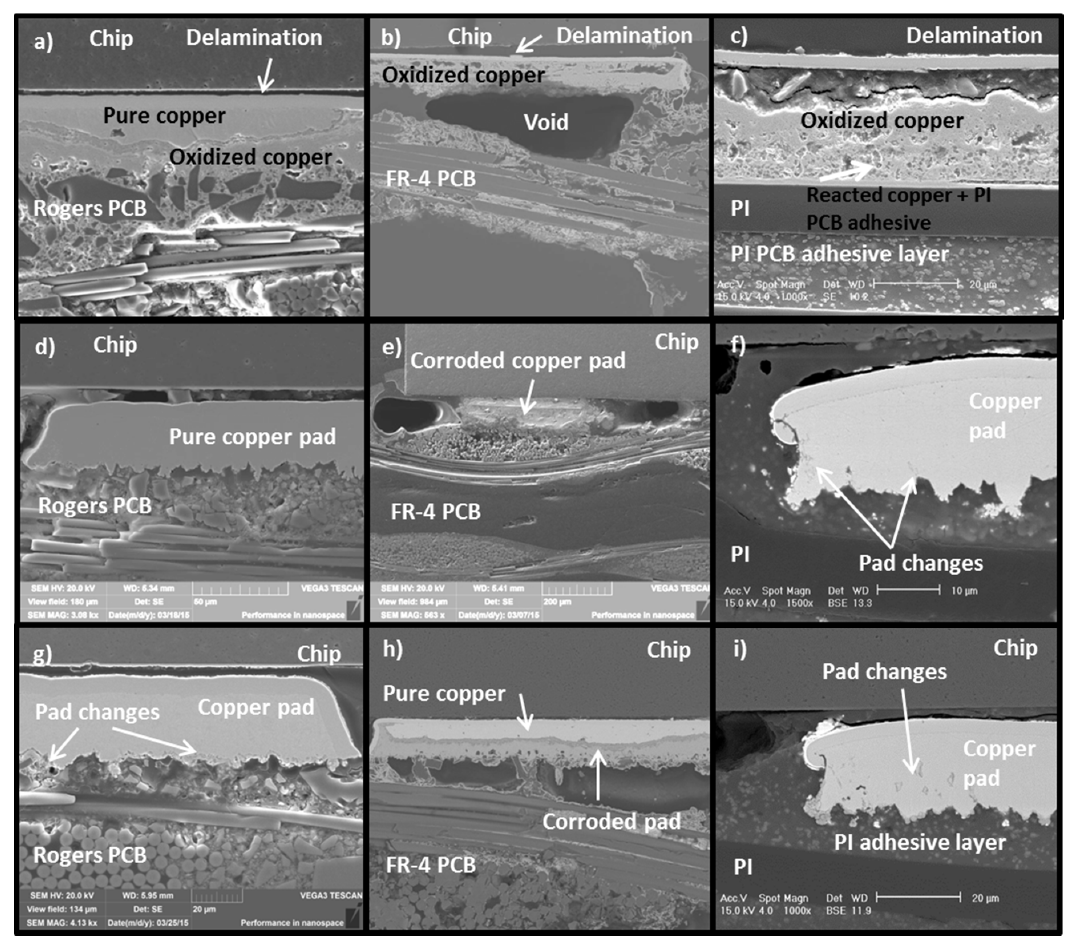
Figure 19. SEM micrographs of different PCBs exposed to varying temperature treatments. Top row: Cross ‐ section after 3000 h at 200 °C for ( a ) Rogers PCB; ( b ) FR ‐ 4 PCB; ( c ) PI PCB. Middle row: Cross ‐ section after 480 h at 200 °C for ( d ) Rogers PCB; ( e ) FR ‐ 4 PCB; ( f ) PI PCB. Bottom row: Cross ‐ section after 60 h at 240 °C for ( g ) Rogers PCB; ( h ) FR ‐ 4 PCB; ( i ) PI PCB.